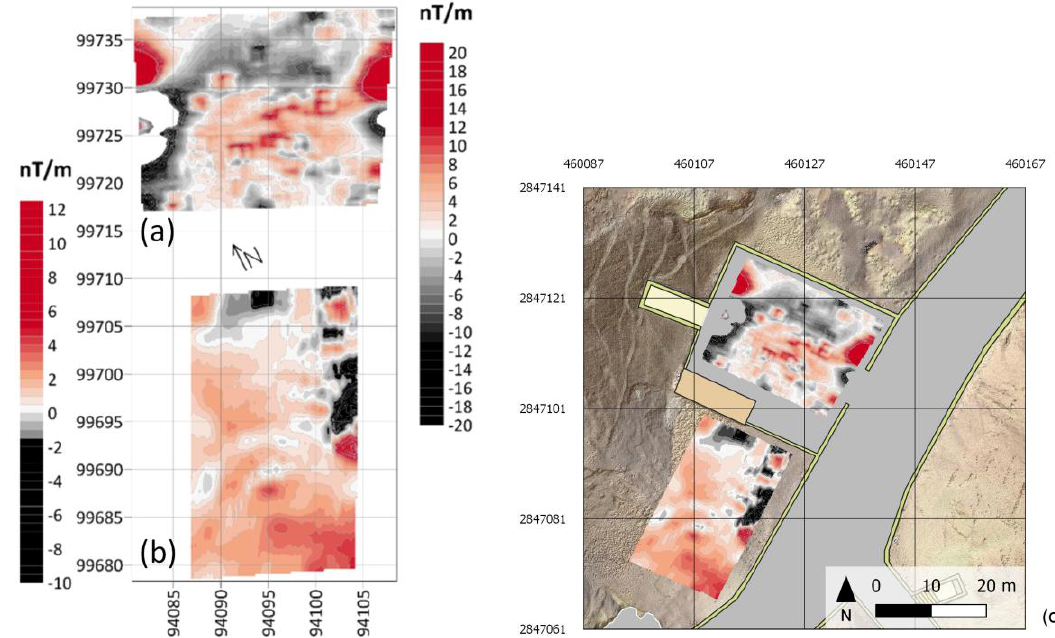
Figure 16. VGTMF map (local coordinates system) of ( a ) MAG-3 and ( b ) MAG-2 areas. The left color scale refers to MAG-2, the right color scale refers to MAG-3. The color scales have different ranges to enhance the peculiarity of the two areas. In ( c ) the same VGTMF maps are integrated in the geomatics GIS environment (georeferenced in the UTM WGS 84 system).